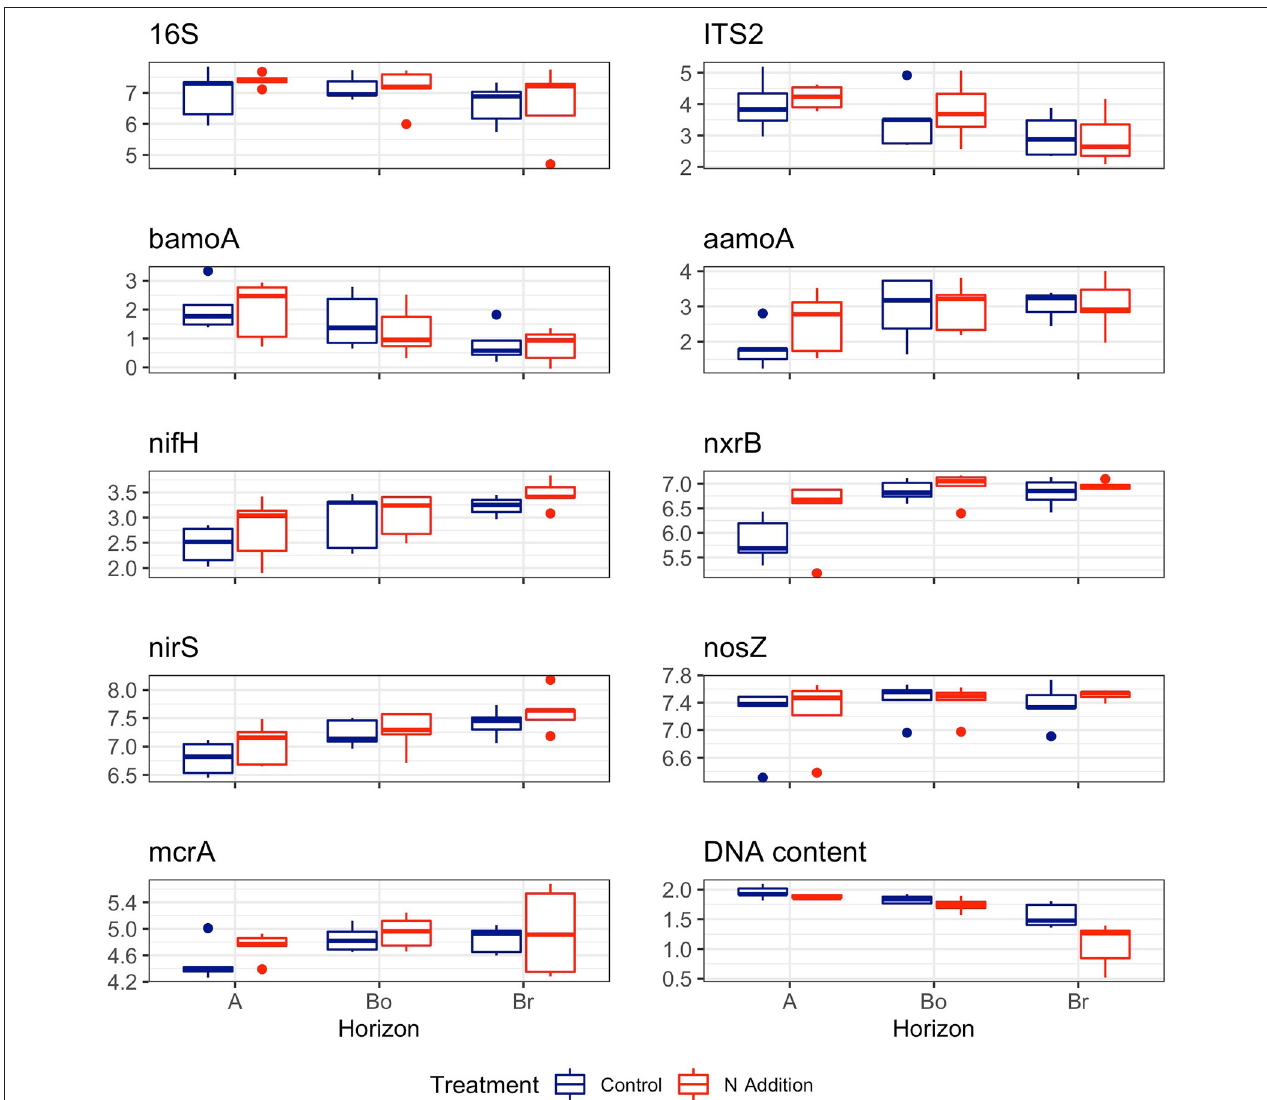
FIGURE 2 | DNA content and abundances of bacterial (16S), fungal (ITS2), and C- and N-cycling genes in the horizons of the mineral soil in the control and N-addition plots ( n = 5; A, A horizon; Bo, oxic B horizon; Br, reduced B horizon). Gene copies (as log10) were given per µ g DNA.